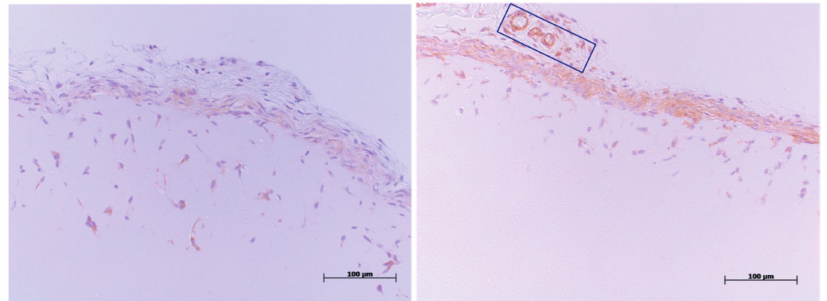
Figure 7. Representative images of the CD31 immunohistochemistry staining. CD31 positive cells (i.e., endothelial cells) are stained and visible as a brown staining. In the right figure, a blood vessel in the membrane surrounding the Matrigel plug is stained and serves as an internal positive control. In the box in the right panel some CD31 positive vessel structures in the surrounding granulation tissue around the plug can been seen, demonstrating the specificity of the endothelial cell staining. The left panel is representative of a section with a deeper ingrowth of endothelial cells. The maximal depth to the ingrowth as well as the CD31+ area in the plug were quantified using Image J